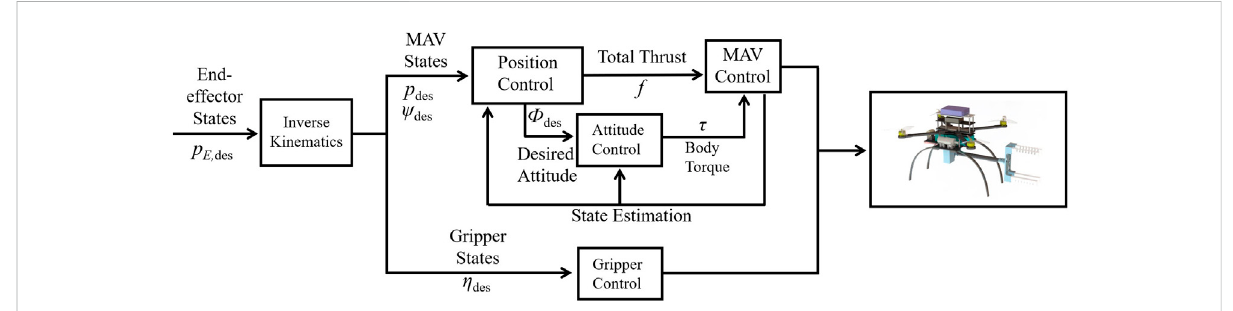
FIGURE 4 A cascaded tracking controller is used in this work to regulate both the vehicle and